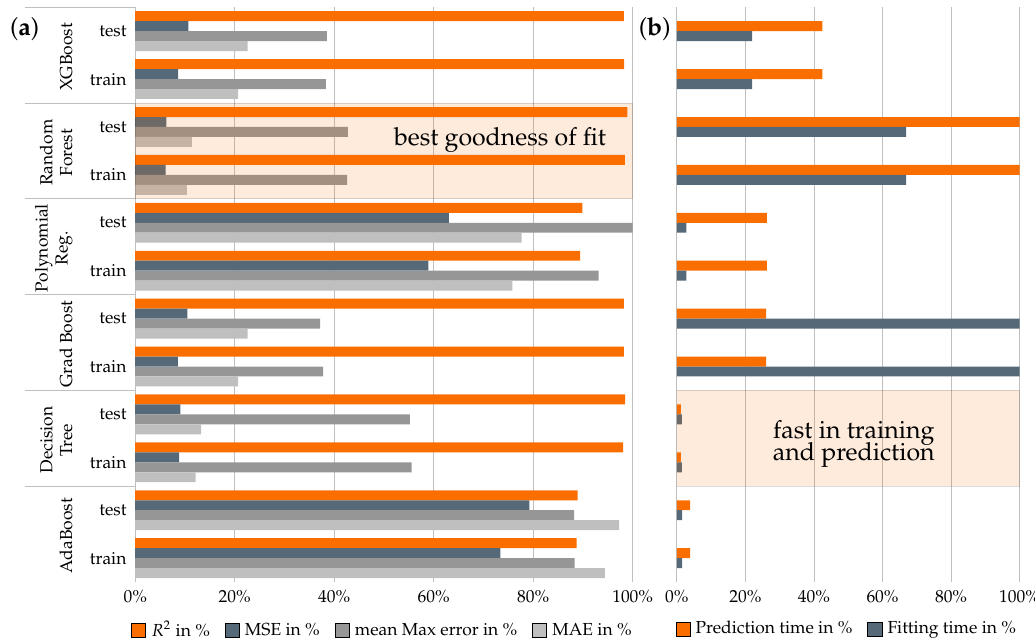
Figure 11. Comparison of model evaluation metrics without outliers for all investigated data-driven approaches for the demonstrator structure: ( a ) Error ( R 2 , mean squared error (MSE), mean MAX error, mean absolute error (MAE)); ( b ) times for training and prediction.